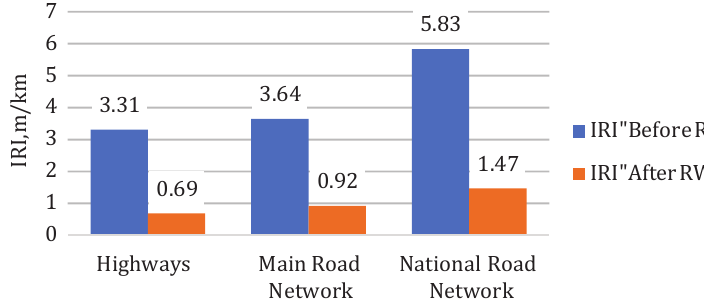
Figure 6. Change in IRI after major repair